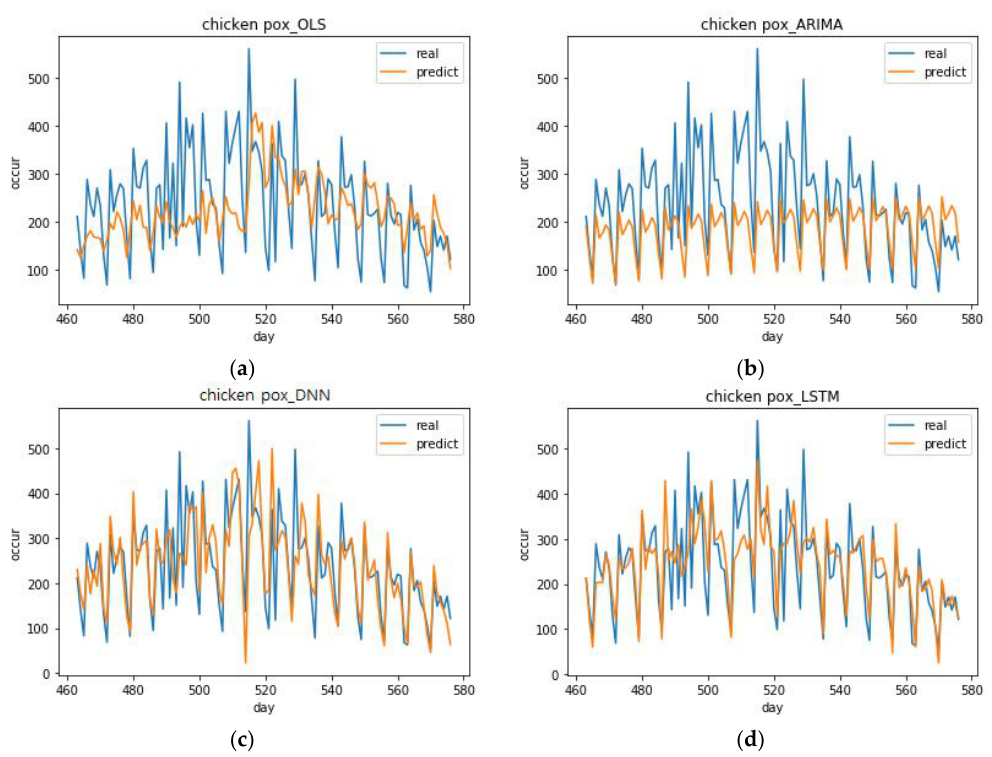
Figure 7. Top performing chickenpox predictions for each analysis method. ( a ) Prediction graph of OLS model in chickenpox, ( b ) Prediction graph of ARIMA model in chickenpox, ( c ) Prediction graph of DNN (1, 2, 1) model with the best performance in chickenpox, ( d ) Prediction graph of LSTM (5, 4, 3) model with the best performance in chickenpox.